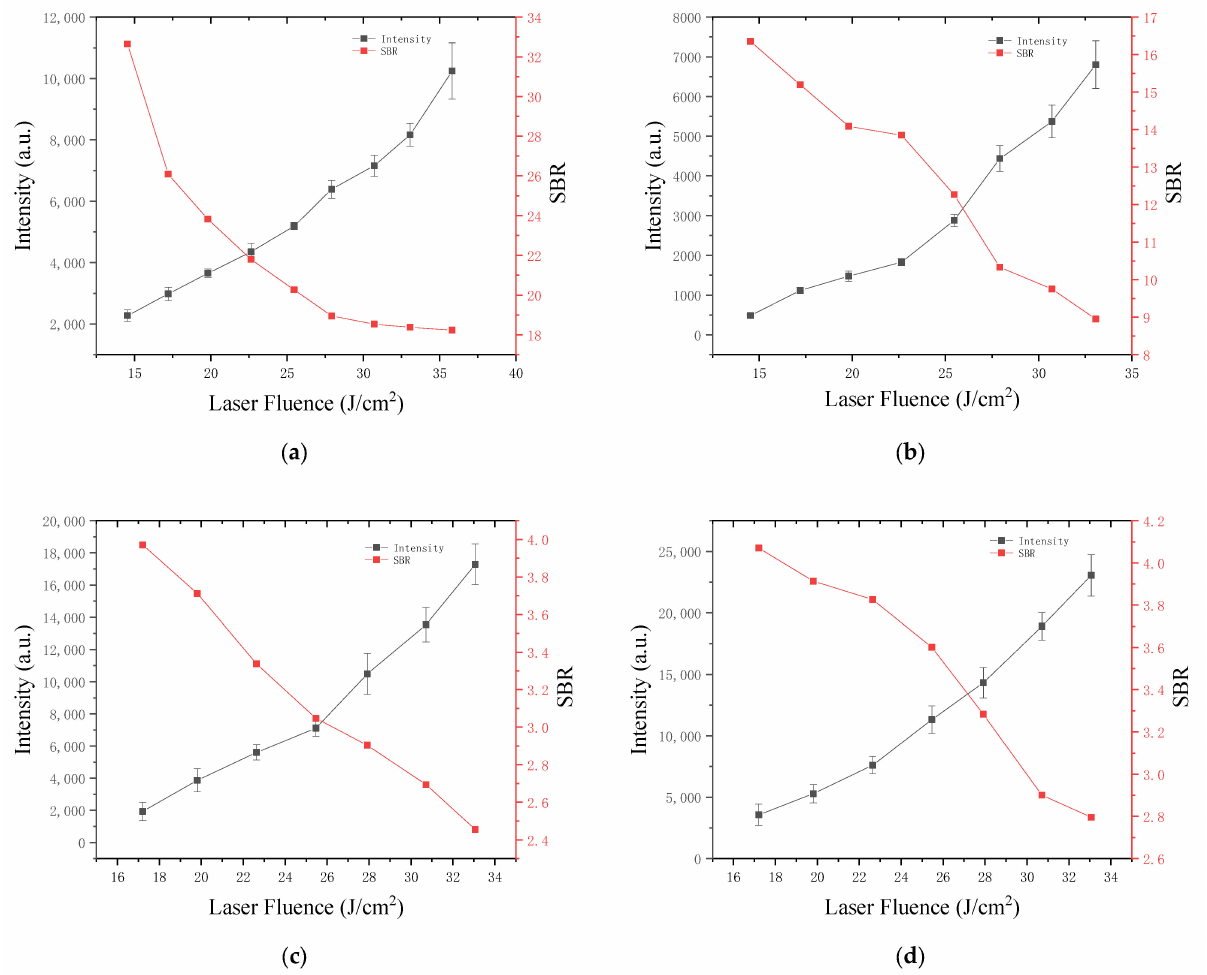
Figure 4. Optimization of laser fluence on the emission of ( a ) Cr; ( b ) Cu; ( c ) Pb; ( d )